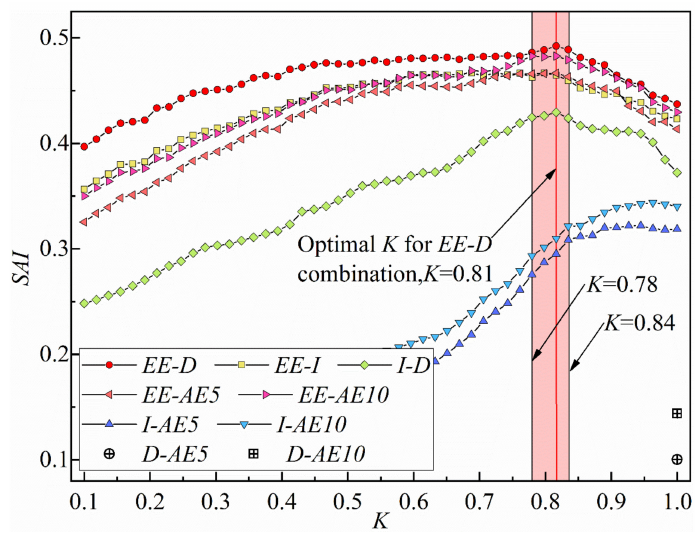
Figure 8. Sensitivity index of the rainfall variable combinations under different parameter K.